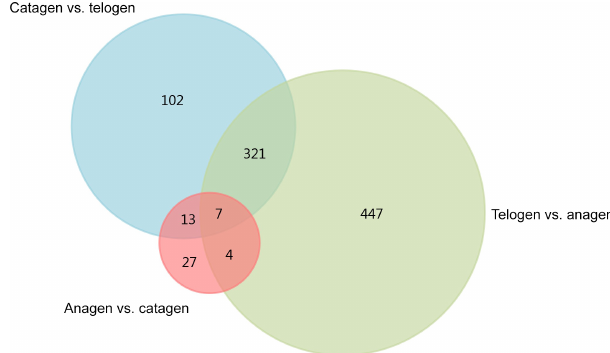
Figure 1. Venn diagram of the construction of DEGs.